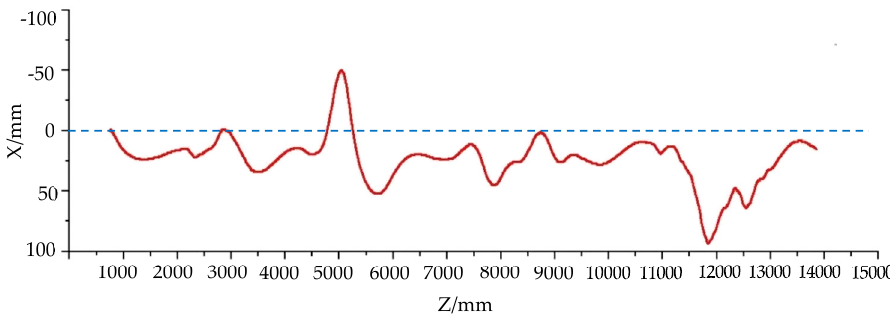
Figure 31. The height trace of the robot while passing through the obstacle terrain simulation.